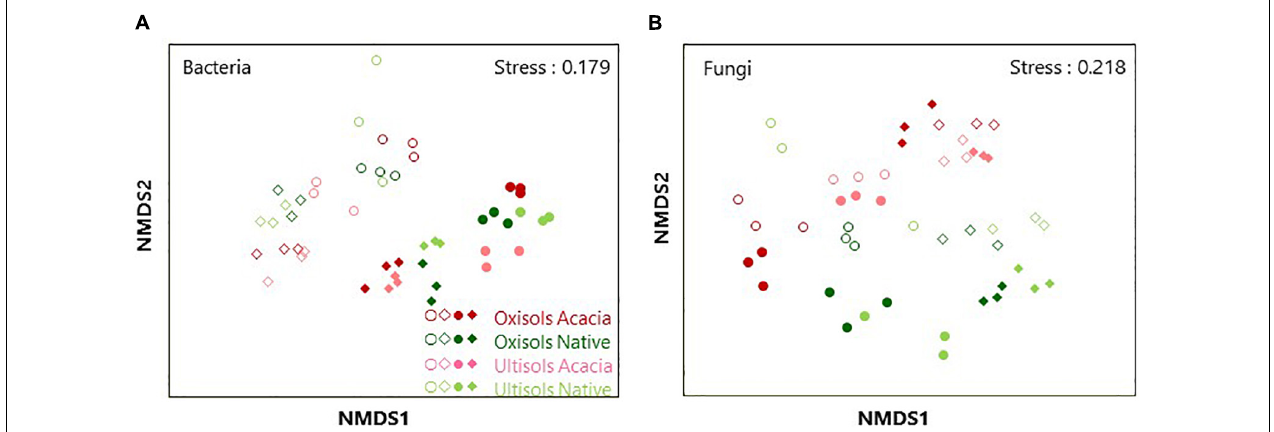
FIGURE 1 | Non-metric multidimensional scaling (NMDS) ordination using Bray-Curtis dissimilarity index of (A) bacterial and (B) fungal OTU distribution for surface root (blank squares), subsurface root (blank circles), surface soil (filled squares) and subsurface soil (filled circles).